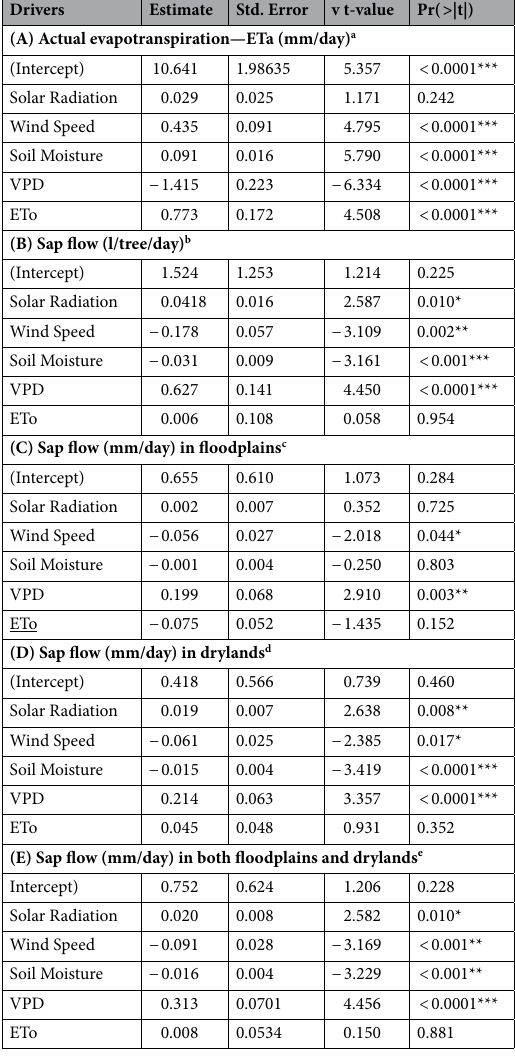
Table 3. Results of multiple linear regression of daily water use of Prosopis across 11 months and pedo- climatic factors. a Residual standard error: 1.148 on 310 degrees of freedom, Multiple R-squared: 0.3179, Adjusted R-squared: 0.3069, F-statistic: 28.9 on 5 and 310 DF, p value: < 2.2e−16. b Residual standard error: 0.7245 on 310 degrees of freedom, Multiple R-squared: 0.1929, Adjusted R-squared: 0.1799, F-statistic: 14.82 on 5 and 310 DF, p value: 4.879e−13. c Residual standard error: 0.3531 on 310 degrees of freedom, Multiple R-squared: 0.05818, Adjusted R-squared: 0.04299, F-statistic: 3.83 on 5 and 310 DF, p value: 0.002212. d Residual standard error: 0.3276 on 310 degrees of freedom, Multiple R-squared: 0.1547, Adjusted R-squared: 0.1411, F-statistic: 11.35 on 5 and 310 DF, p value: 4.59e−10. e Residual standard error: 0.3609 on 310 degrees of freedom, Multiple R-squared: 0.1946, Adjusted R-squared: 0.1816, F-statistic: 14.98 on 5 and 310 DF, p value: 3.521e−13; Asterisks indicate level of significance: *** = < 0.001, ** < 0.01, * = <